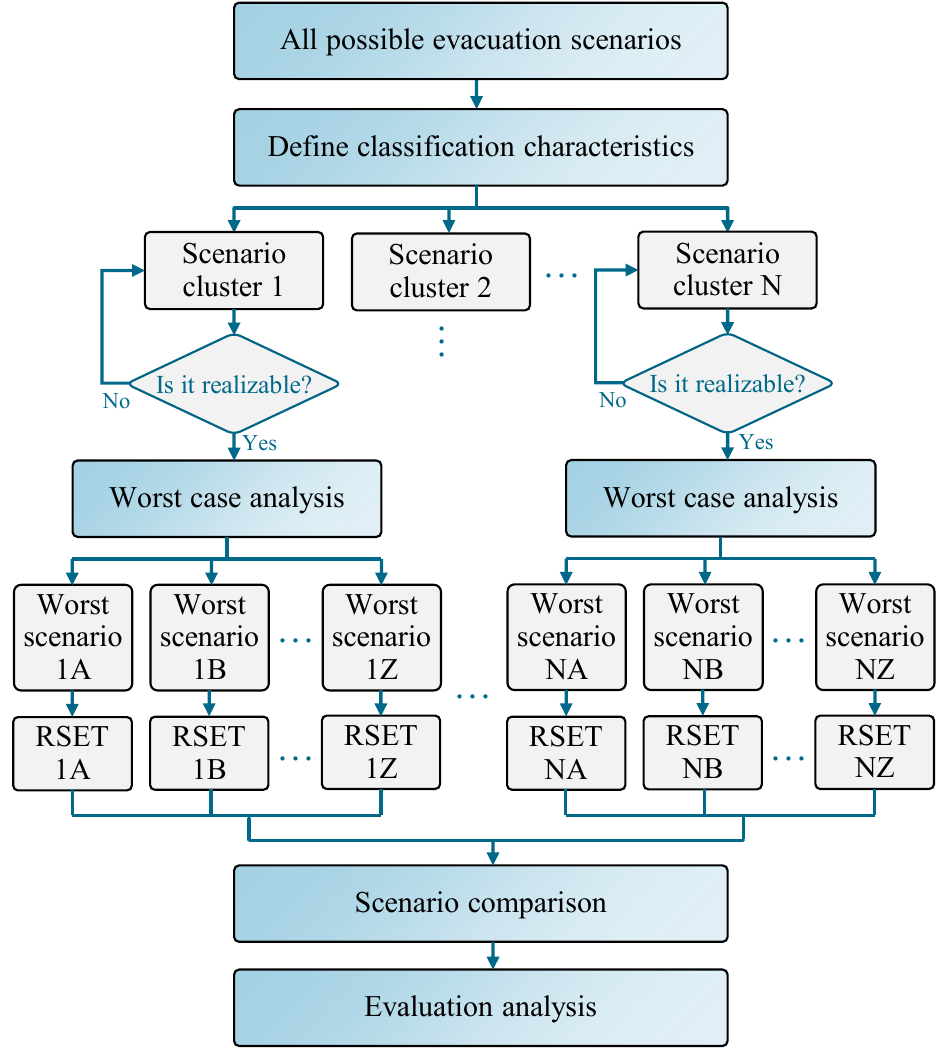
Figure 6. Framework for identifying evacuation scenarios.